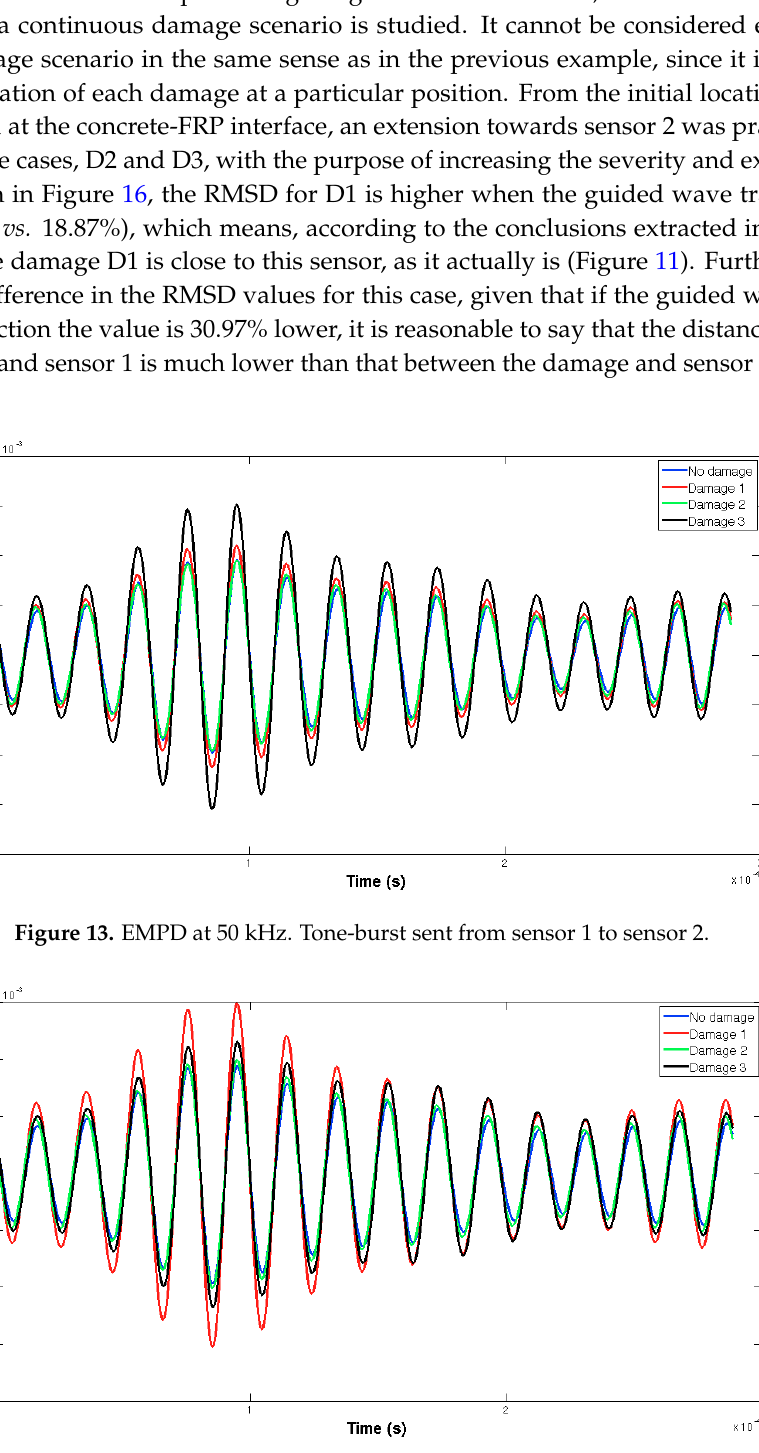
Figure 14. EMPD at 50 kHz. Tone-burst sent from sensor 2 to sensor 1.